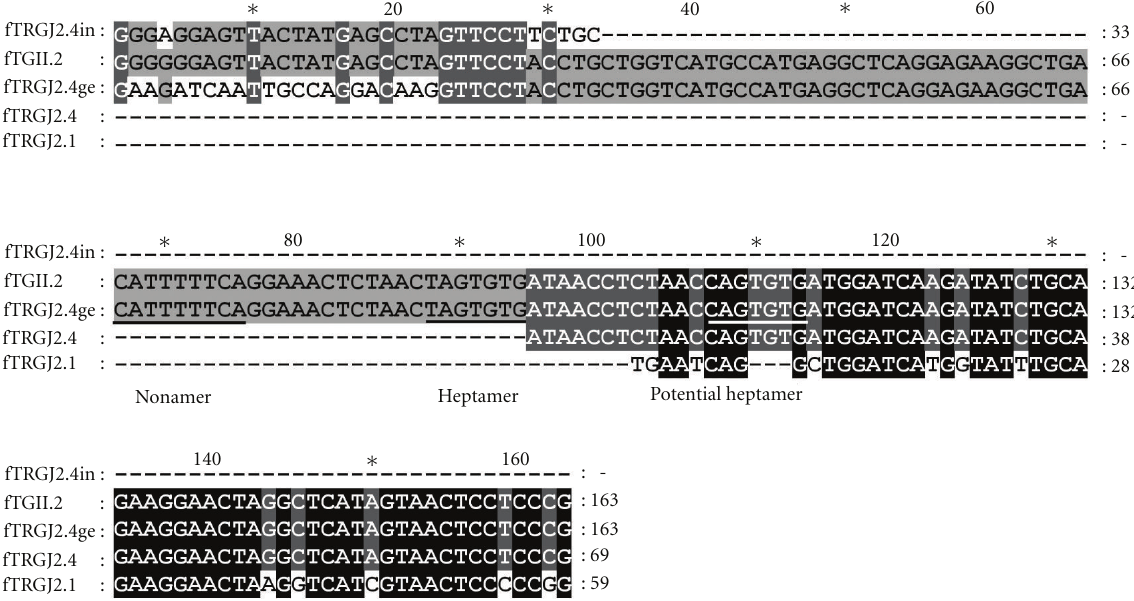
Figure 3: Alignment of fTGII.2 with the fTRGJ2.4, its genomic sequence (fTRGJ2.4ge: gnl | ti | 915239161), and fTRGJ2.4 in inverted orientation (fTRGJ2.4in). The six base pairs at the 3 (cid:2) end of the inverted portion of fTRGJ2.4, are homologous in the inversion, in fTRGJ2.4 and in the genomic sequence upstream of